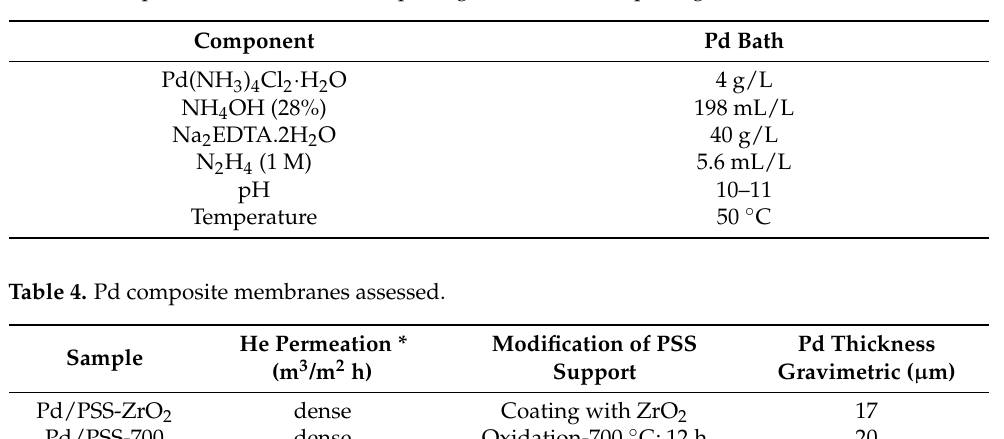
Table 3. Composition of the electroless plating bath for Pd and plating conditions.